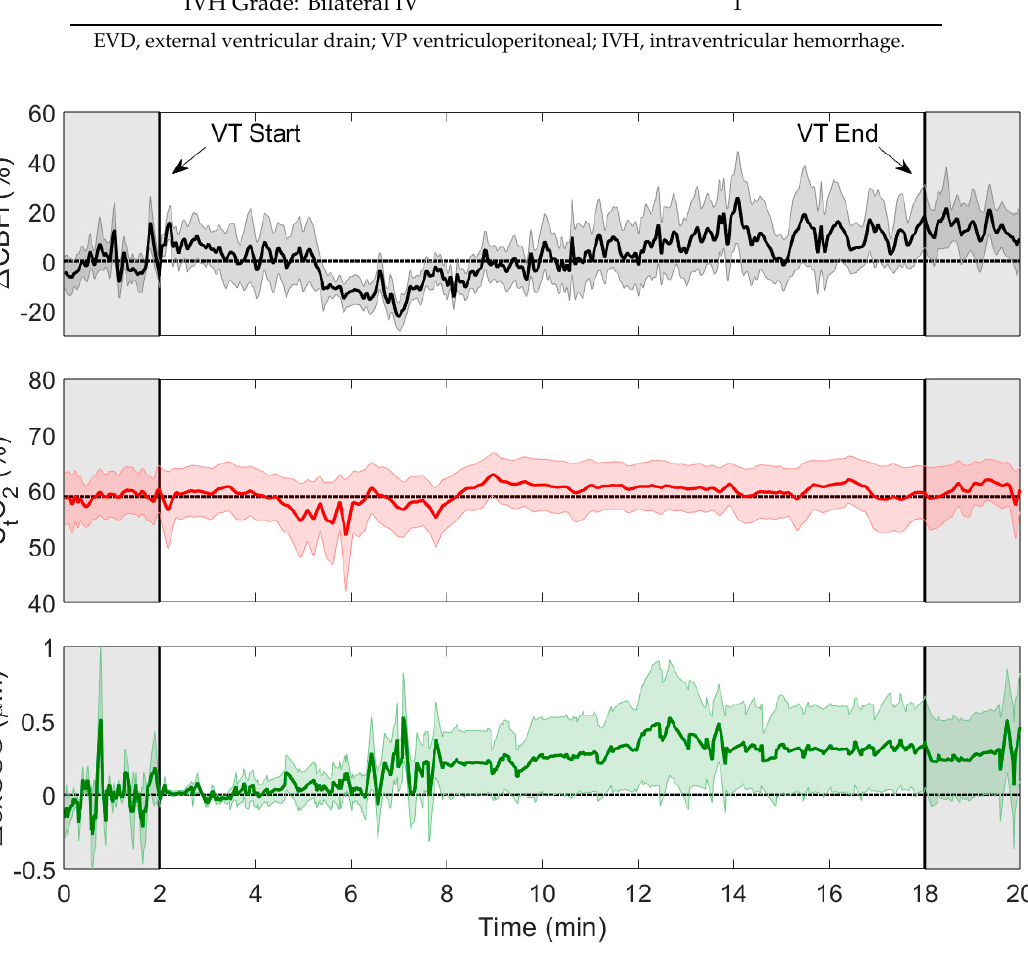
Figure 3. Change in cerebral blood flow index ( ∆ CBFi, n = 10), tissue saturation (S t O 2 , n = 7), and change in oxidation state of cytochrome c oxidase ( ∆ oxCCO, n = 7) averaged across multiple trials over the course of ventricular taps (VT). Data were temporally normalized to the averaged tap duration (16 min) and aligned to VT start and end points. Each time course is displayed with its standard error (shaded background).